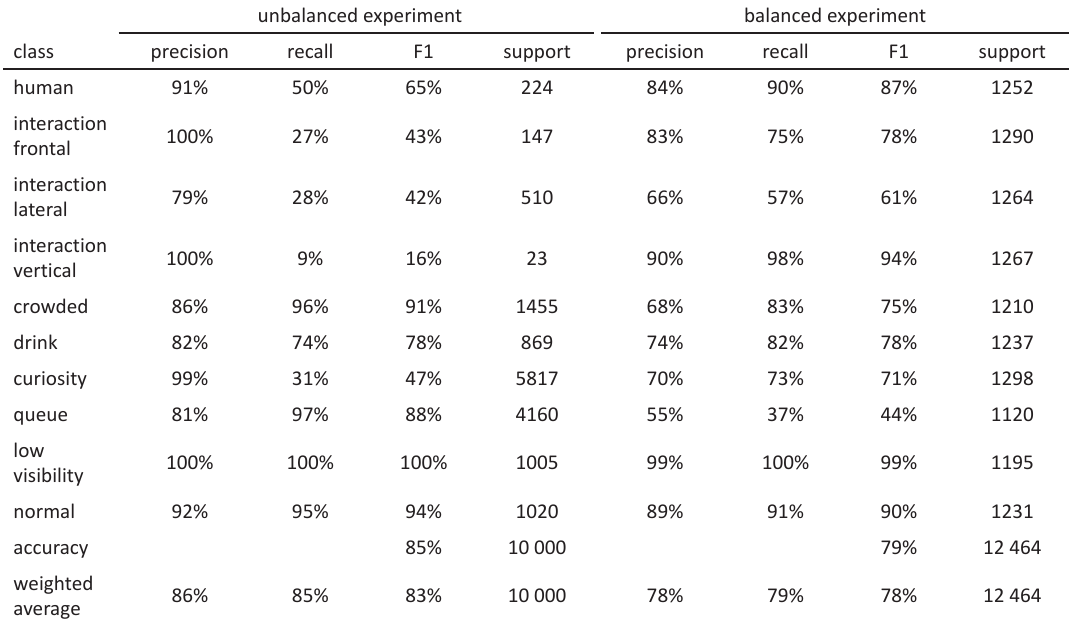
Table 3. Model evaluations